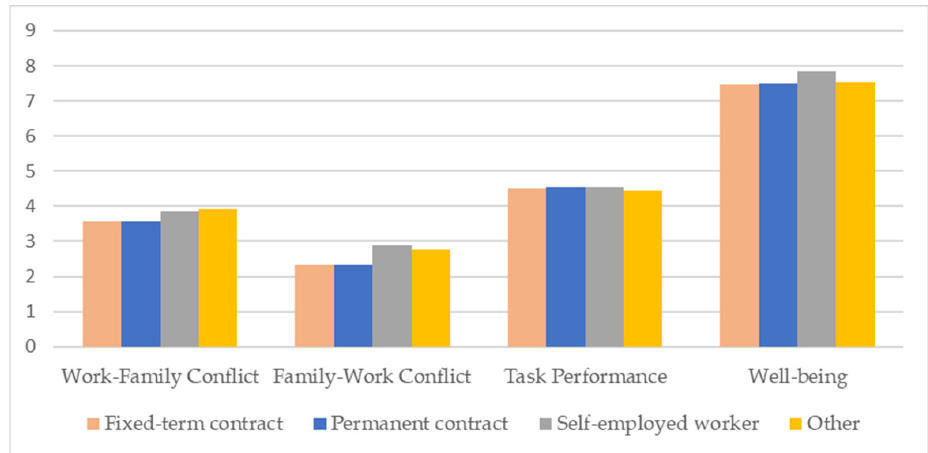
Figure 7. Distribution of variables according to work contract .